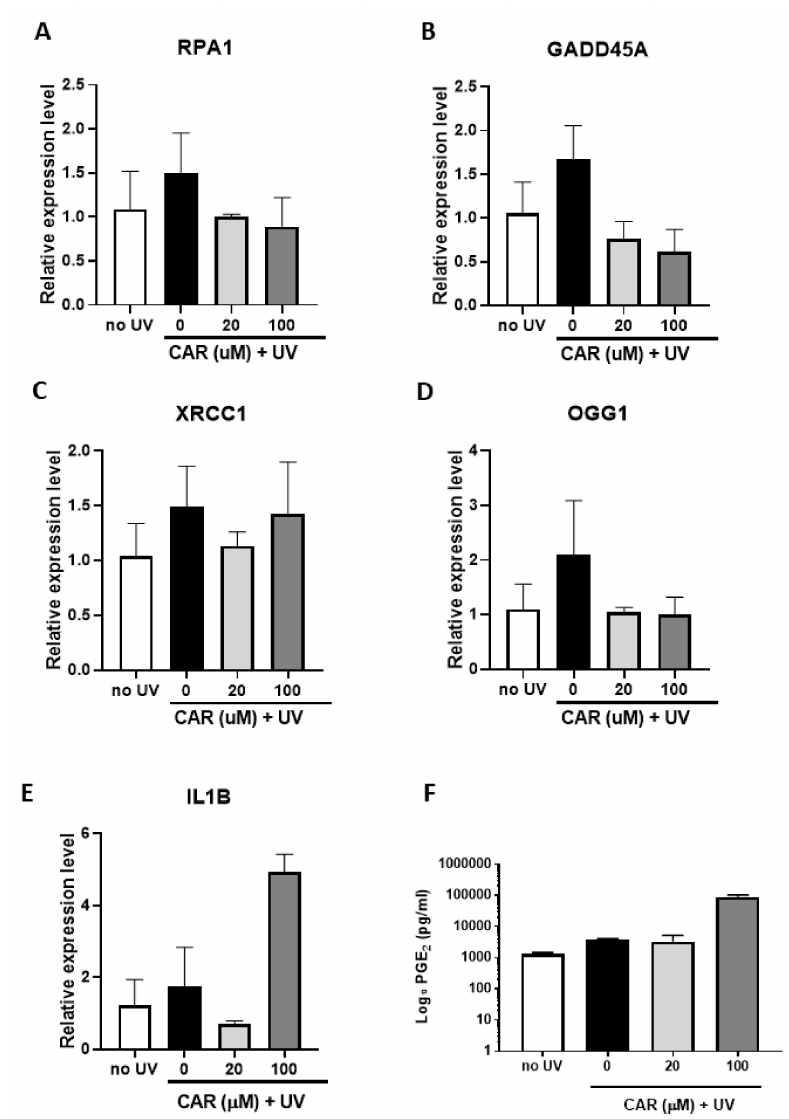
Figure 6. E ff ect of carvedilol and UV-mediated changes in expression of DNA damage / repair genes, proinflammatory marker IL1B , and PGE 2 secretion in 3D human reconstituted skin (EpiDerm TM FT-400). ( A – D ) qPCR results from 3D culture treated by UV 200 mJ / cm 2 and / or carvedilol (20 or 100 uM in media) for RPA1 , GADD45A , XRCC1 , and OGG1 . ( E ) qPCR results of IL1B . ( F ) PGE 2 levels determined by enzyme-linked immunosorbent assay (ELISA) in culture media from untreated or UV-irradiated 3D culture treated with DMSO or carvedilol. GAPDH was used as a normalization control for qPCR and the data are expressed as mean +/ − SE; n =